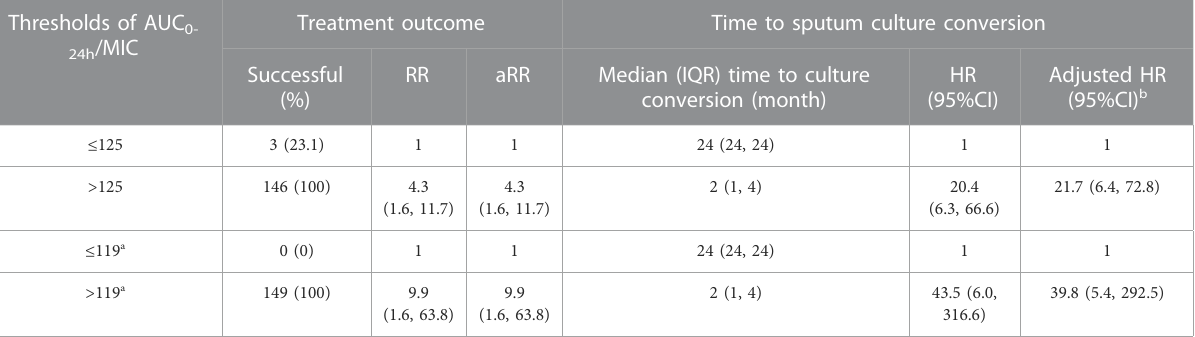
TABLE 5 Validation of CART-derived threshold in relation to the fi nal treatment outcome and time to sputum culture conversion in the validation cohort. Thresholds of AUC 0-